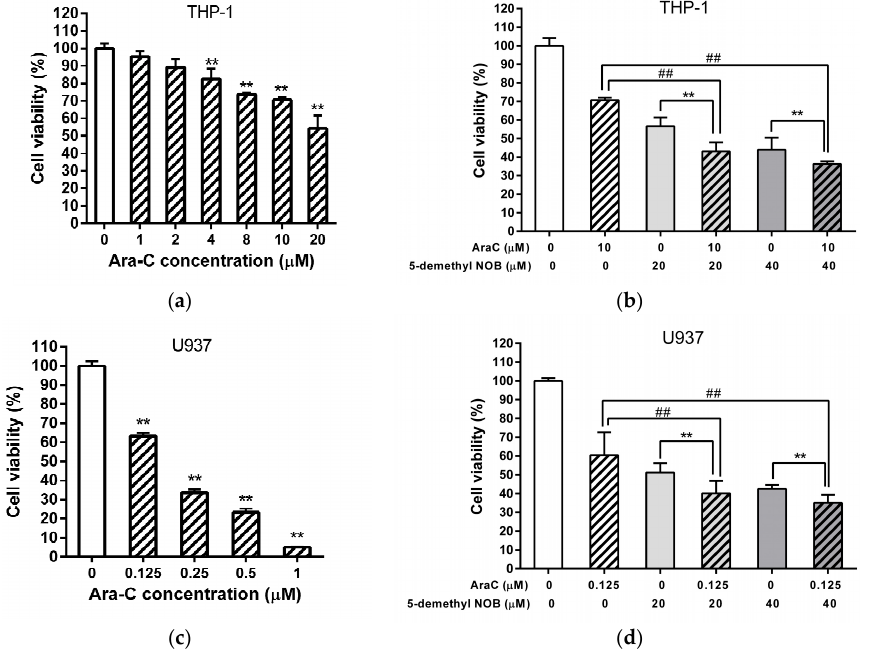
Figure 8. Combination treatment of cytarabine (Ara C) and 5-demethyl NOB in THP-1 and U-937 cells. ( a ) THP-1 cells were treated with Ara C (0–20 μ M) for 48 h. Cell viability was measured by MTT assay. The data represent the mean ± SD of three independent experiments. ( b ) THP-1 cells were pretreated with Ara C (10 μ M) for 12 h followed by incubation with vehicle or 5-demethyl NOB (20 or 40 μ M) for an additional 36 h. Cell viability was measured using the MTT assay. ( c ) U-937 cells were treated with Ara C (0–1 μ M) for 48 h. Cell viability was measured by MTT assay. The data represent the mean ± SD of three independent experiments. ( d ) THP-1 cells were pretreated with Ara C (0.125 μ M) for 12 h followed by incubation with vehicle or 5-demethyl NOB (20 or 40 μ M) for an additional 36 h. Cell viability was measured using the MTT assay. The data represent the mean ± SD of three independent experiments. ## p < 0.01 represents significant differences compared to the 5-demethyl NOB-untreated group. ** p < 0.01 represents significant differences compared to the Ara C-untreated group.